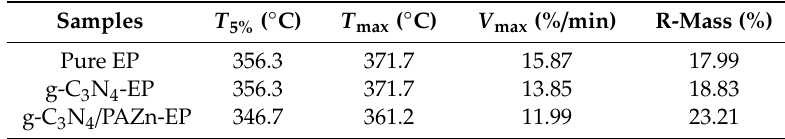
Table 3. TGA and DTG data of EP composites.